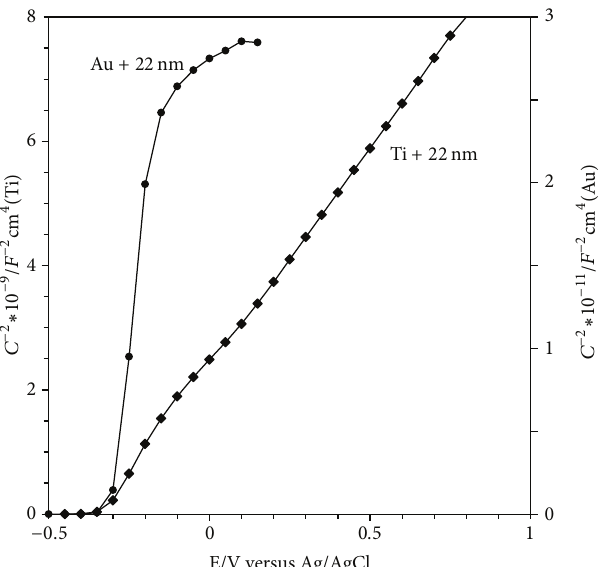
Figure 5: The Mott-Schottky plots obtained at 100 Hz. Note that the scale to the right is related to the Au + 22nm electrode.